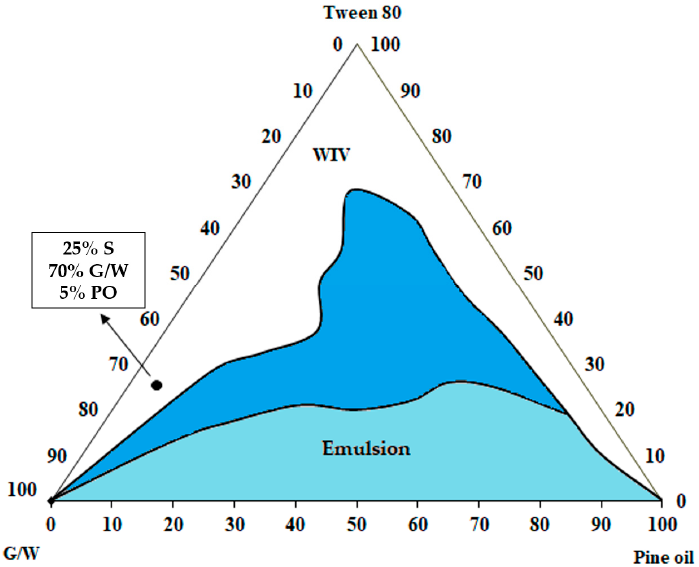
Figure 2. Ternary phase diagram of the system formulated (water/glycerol, pine oil, and Tween